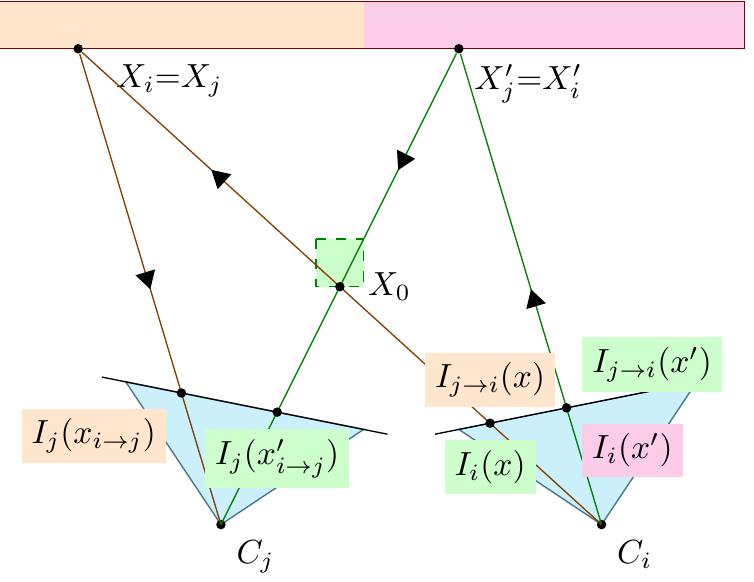
Figure 3. An inserted object at X 0 (i.e., absent from mesh) introduces inconsistencies: I i ( x ) (cid:54) = I j → i ( x )